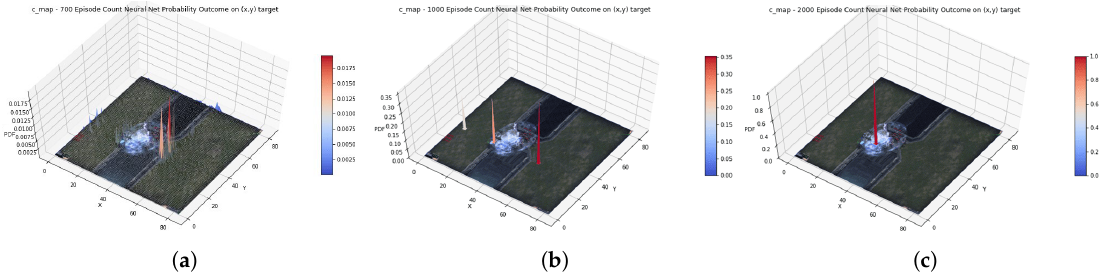
Figure 10. Probability Density Functions (PDF) of global network for ‘( c ) Combination with Spell’ Scenario each describing ( a ) 700 episodes, ( b ) 1000 episodes, and ( c ) 2000 episodes,